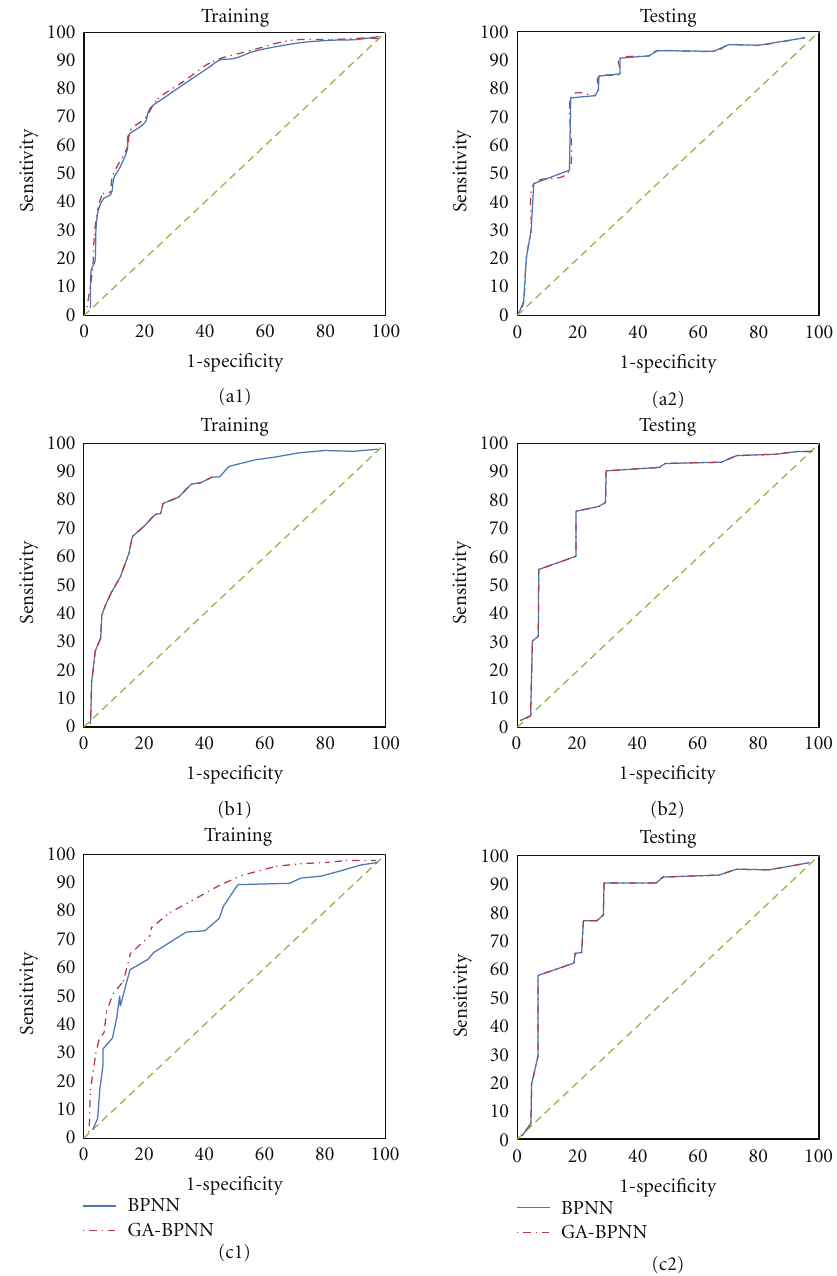
Figure 5: The ROC curves of the original BPNN and the GA-based BPNN for di ff erent ranges, (a1) and (a2) − 0.5 to 0.5 range for the training and testing data, (b1) and (b2) − 1 to 1 range for the training and testing data, (c1) and (c2) − 5 to 5 range for the training and testing